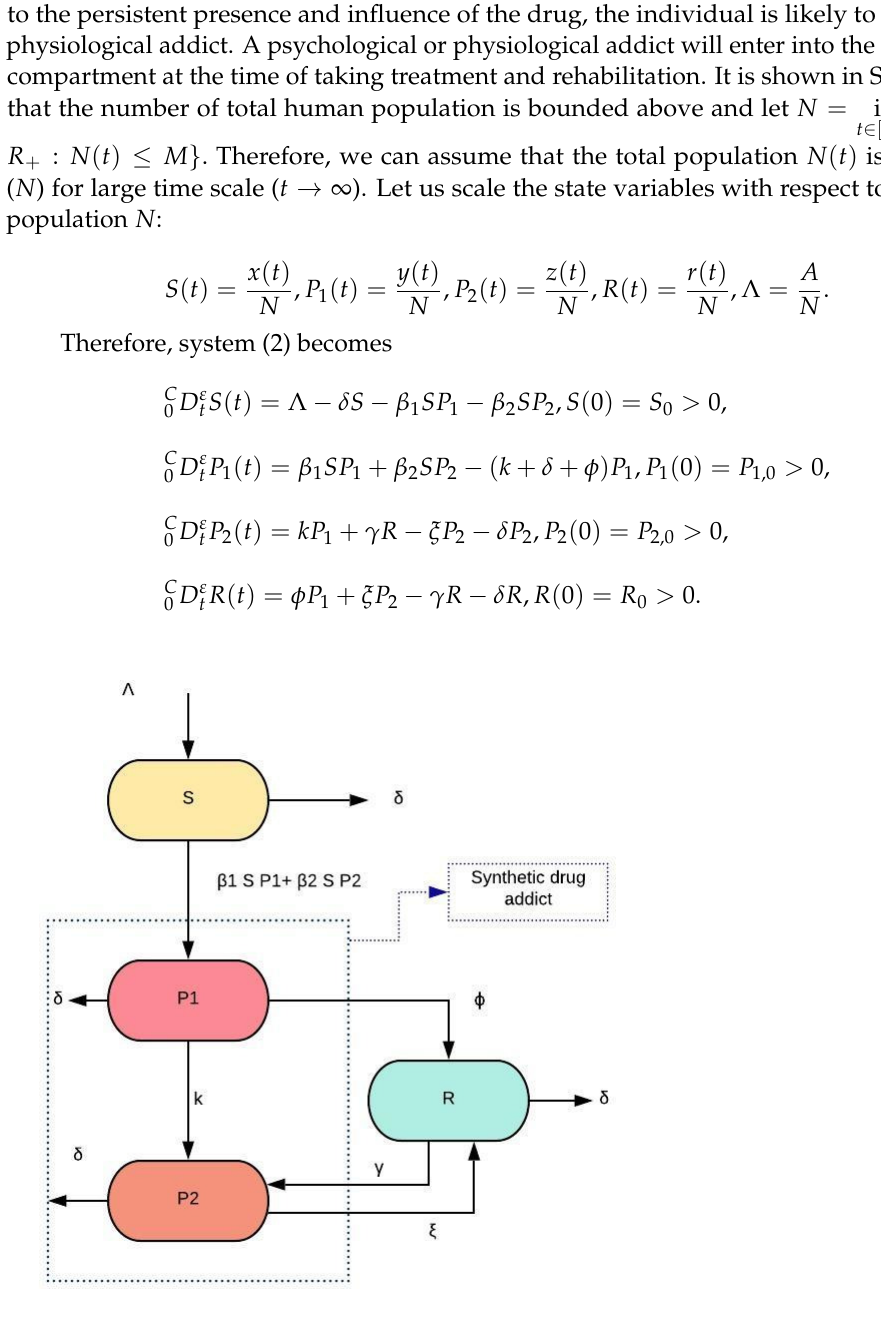
Figure 1. Schematic diagram of system